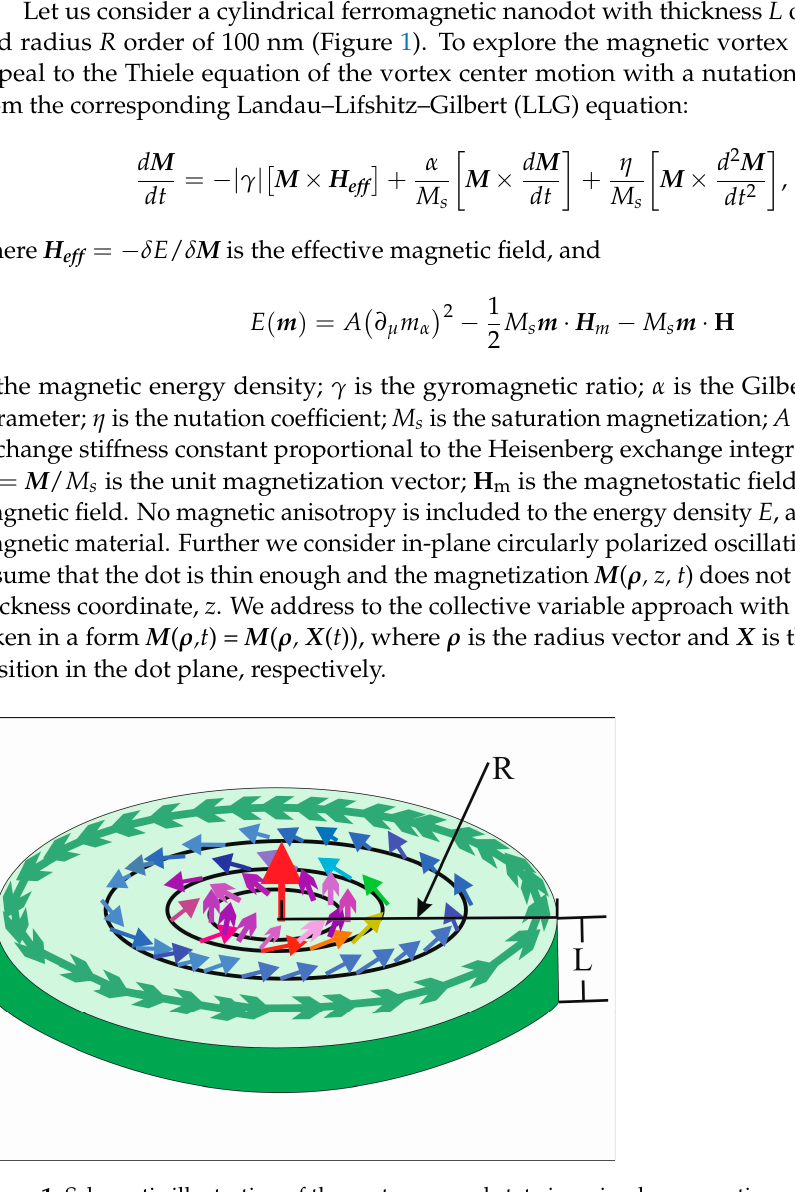
Figure 1. Schematic illustration of the vortex ground state in a circular magnetic nanodot.